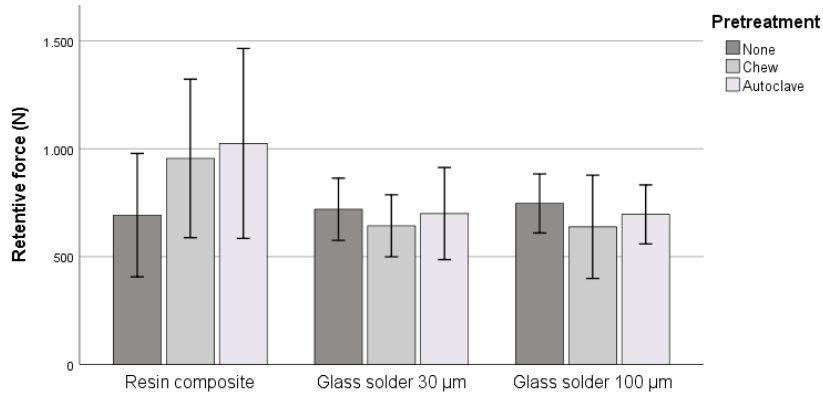
Figure 3. Retentive forces of the three groups after different pretreatment protocols.